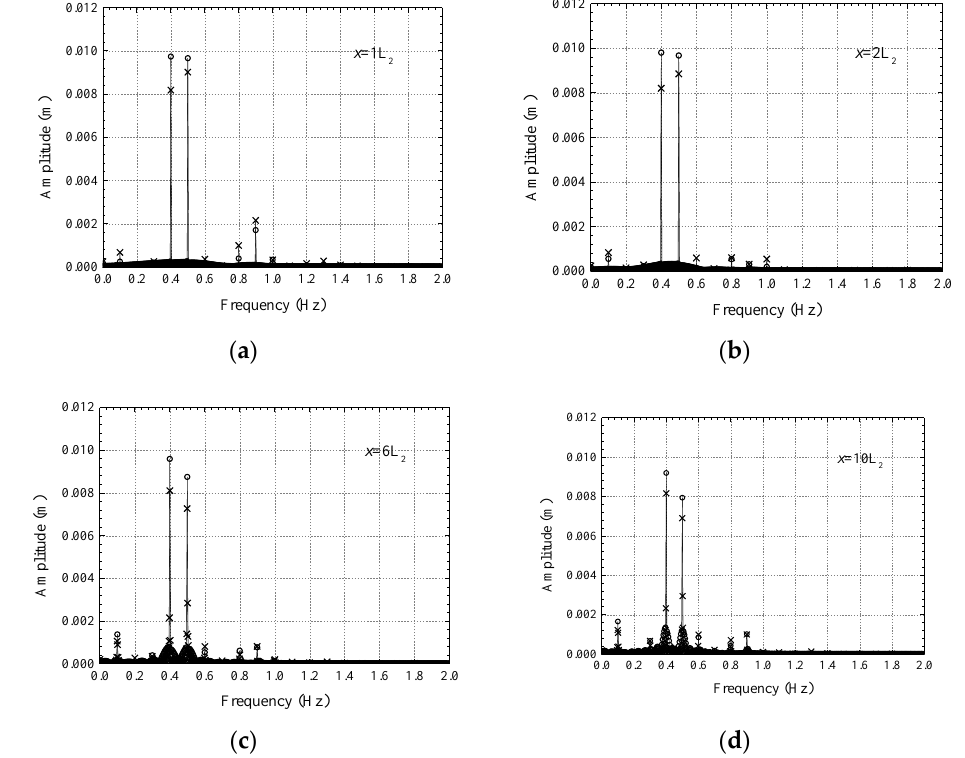
Figure 8. Frequency domain plots of wave simulation results at X = 1L 2 ( a ), X = 2L 2 ( b ), X = 6L 2 ( c ), X = 10L 2 ( d ) for the MIKE 21 BW model ( ○ ) and the Navier – Stokes model ( ╳ ) (operating condition C1).